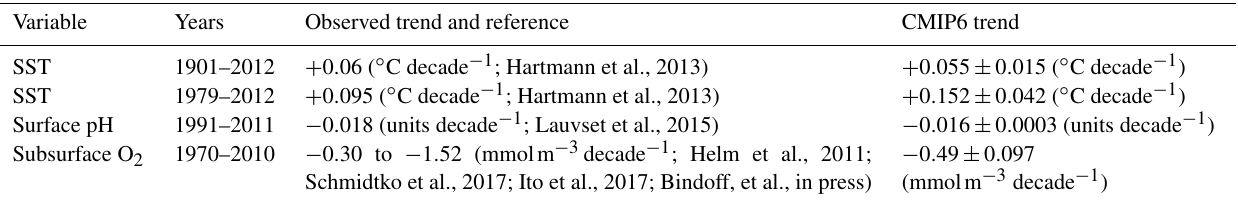
Table 3. Historical trends in ocean impact drivers in observations and CMIP6 models. Observed multi-decadal historical trends in global mean sea surface temperature, surface pH, and subsurface O 2 (averaged between 100 and 600m) and the corresponding trend in the CMIP6 ensemble. Uncertainty estimates are the inter-model